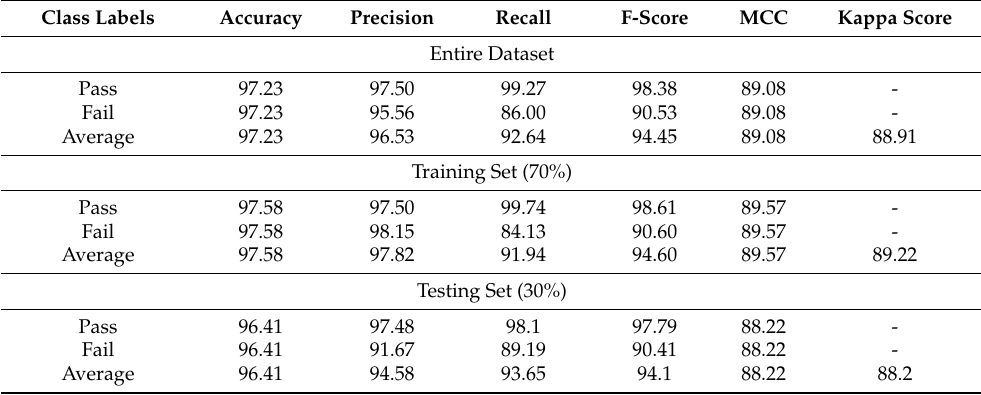
Table 2. Result analysis of FSSML-EDM technique with distinct measures and